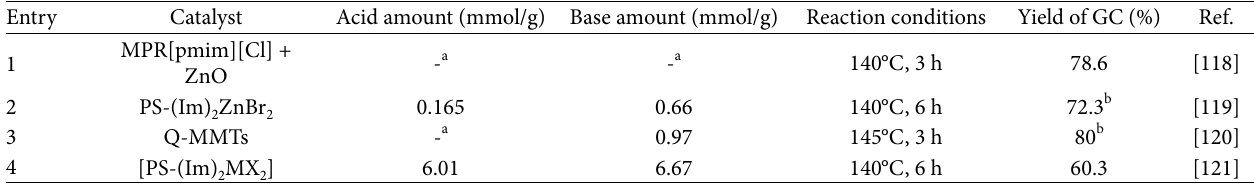
Table 4: Catalytic glycerolysis of urea to GC using ILs-based catalyst.